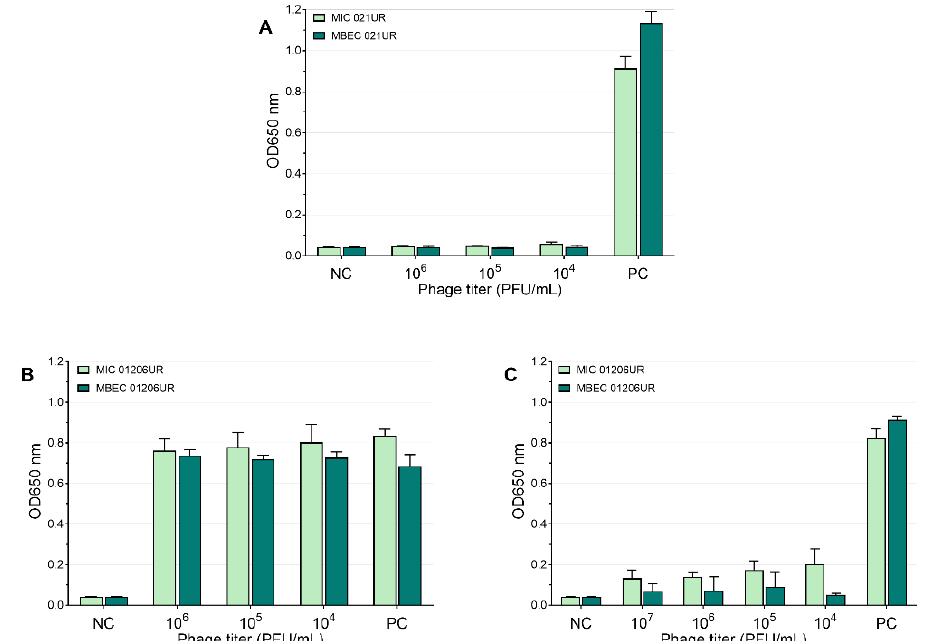
Figure 5. Pyobacteriophag effect at different concentrations represented as mean values. ( A ) MIC and MBEC in 021UR; ( B ) MIC and MBEC in 01206UR before adaptation; ( C ) MIC and MBEC in 01206UR after adaptation.